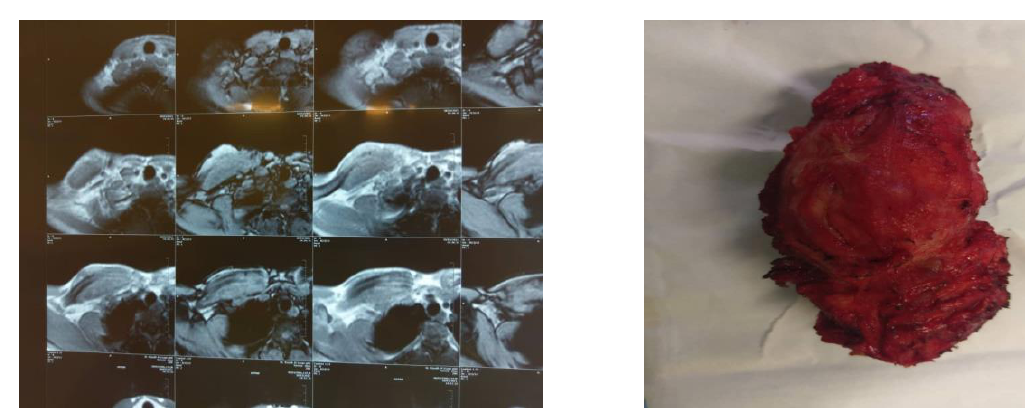
Figure 2: Magnetic resonance imaging (MRI) of chondroblastic osteosarcoma. A T1-weighted imaging of the right clavicle demonstrated a cortical expansion and bone destruction.